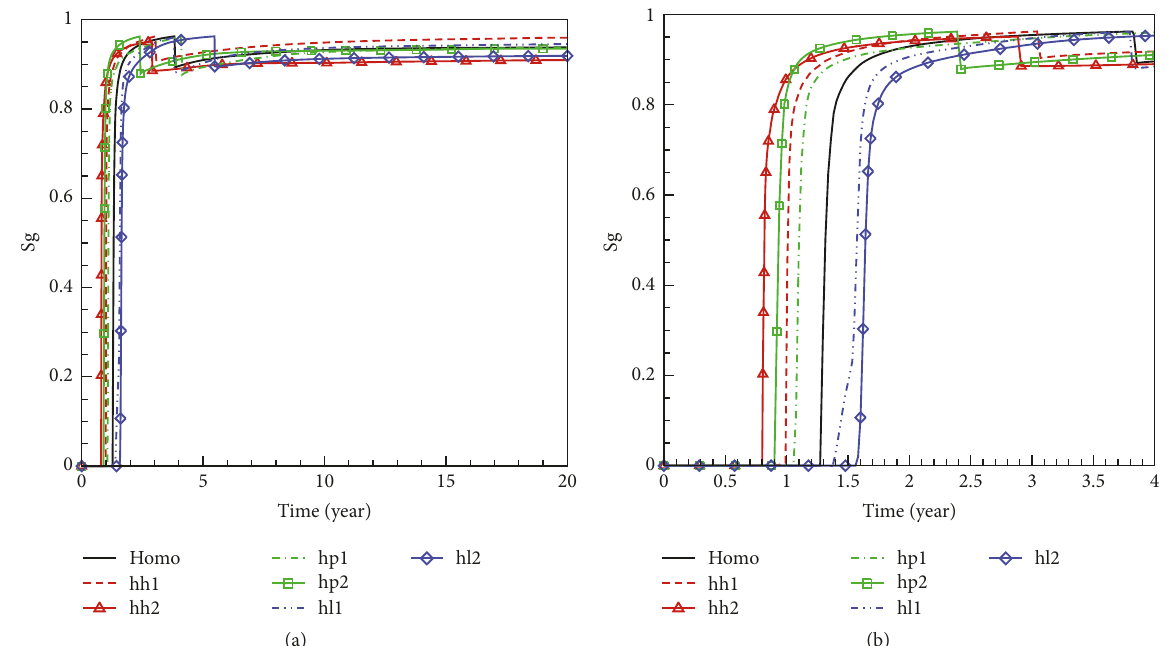
Figure 4: Variation of CO 2 saturation in output fluids versus time at the wellhead.